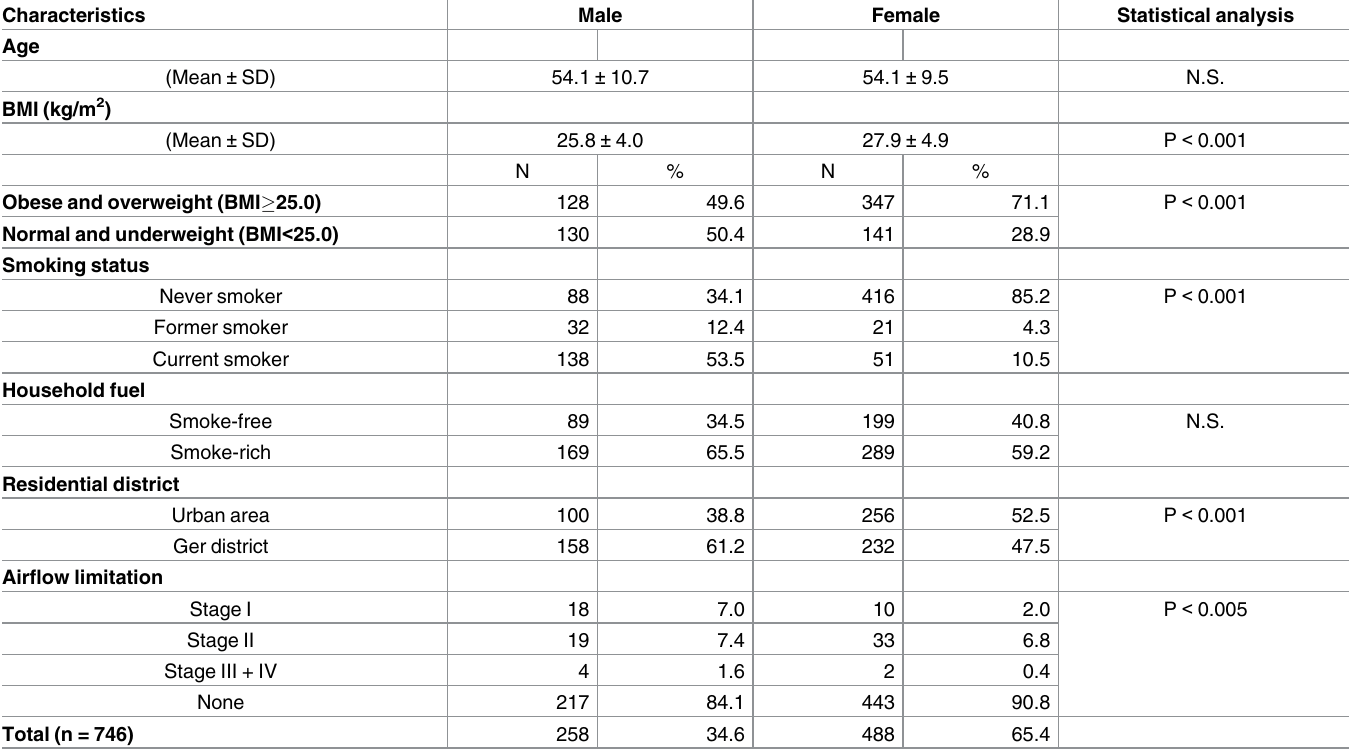
Table 1. Characteristics of the study subjects with valid spirometry.